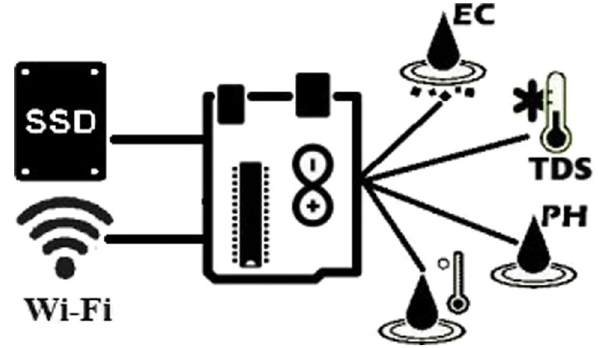
Fig. 1 The architecture of sensor